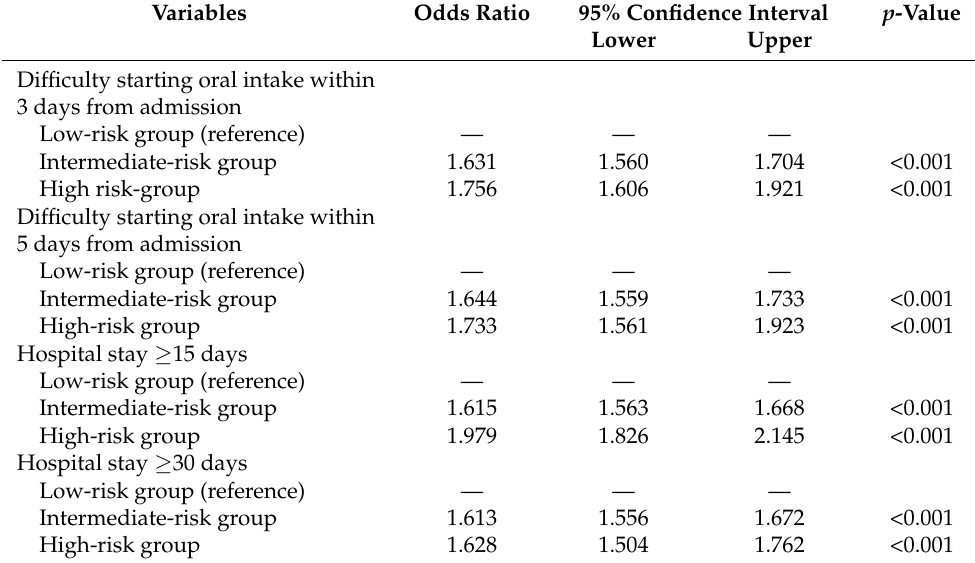
Table 4. Multiple logistic regression analysis for secondary